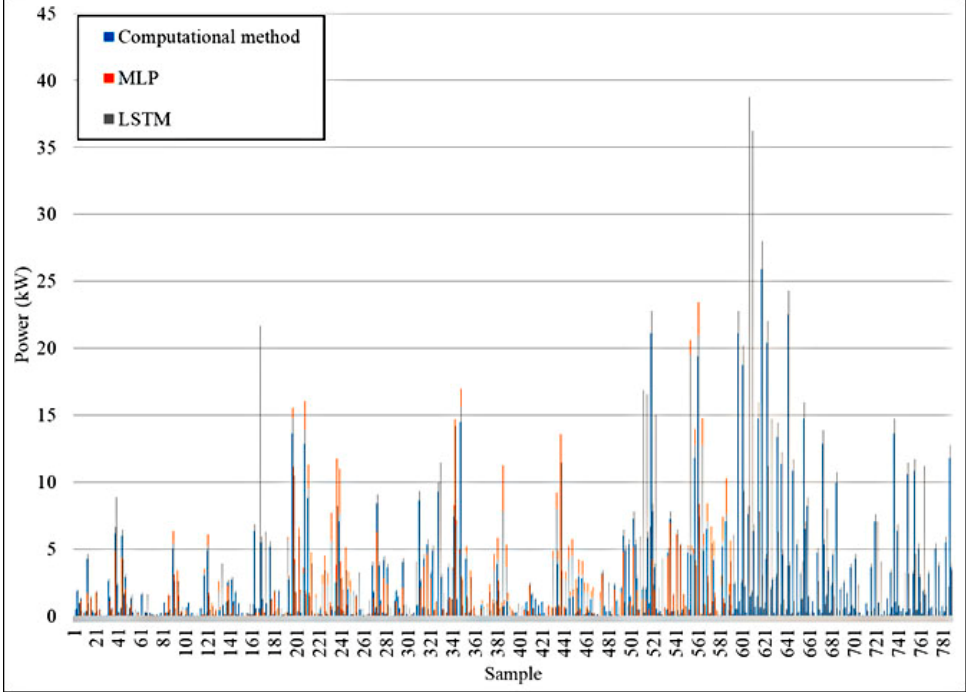
Figure 10. Two approaches of calculating the output power of Searaser in an experimental test period.